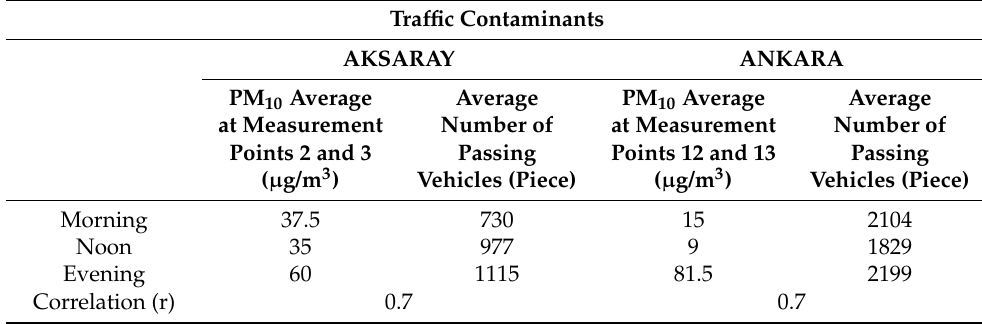
Table 3. Evrenkoy Street traffic-related pollution—correlation of average PM 10 value at measurement points and average number of vehicles passing